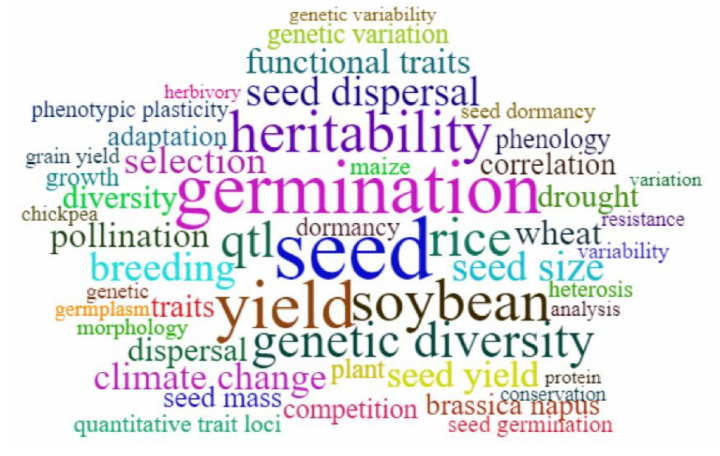
Figure 5. Top 50 frequently used keywords represented by the wordcloud. Labels are usually single words, and the size and color of labels represent different